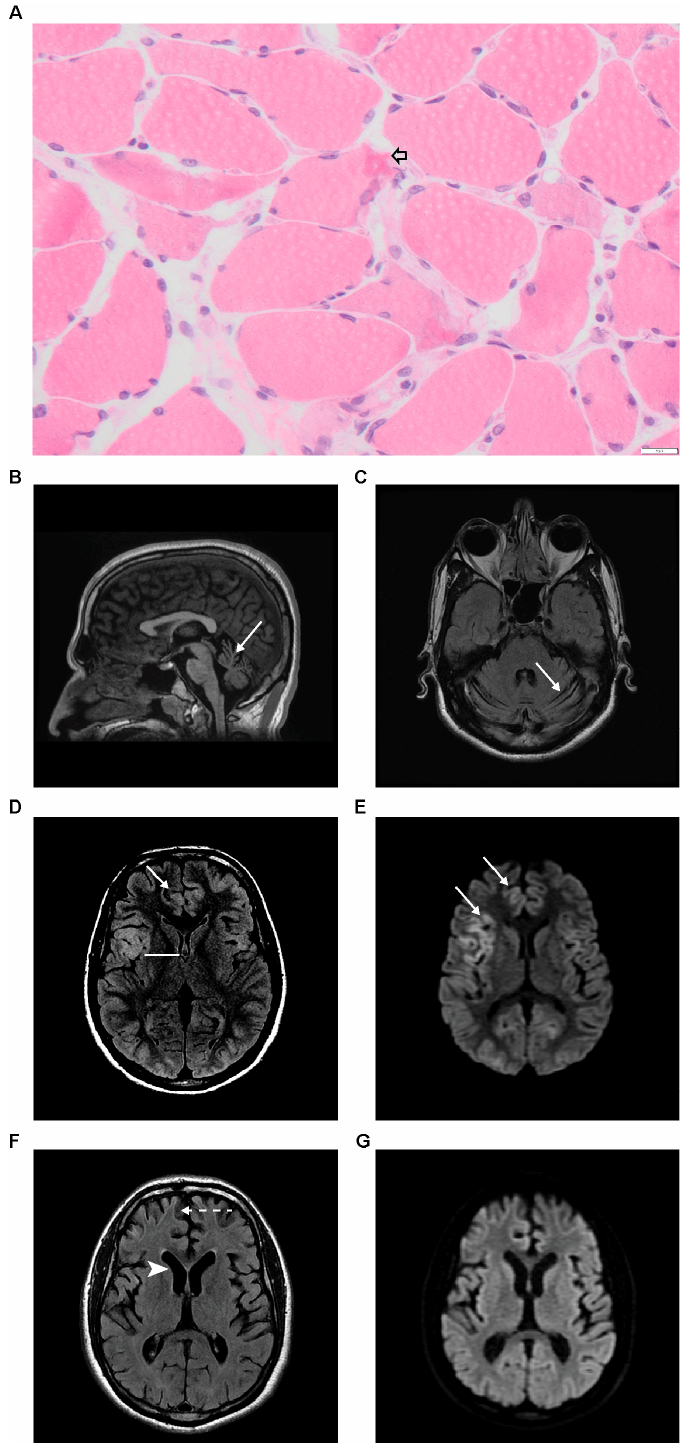
Figure 1. Muscle biopsy and neuroimaging findings in adult patient with NAXD deficiency. ( A ) Skeletal muscle showing rounded eosinophilic cytoplasmic bodies (arrow). Haematoxylin and eosin-stained section taken at 400× magnification (scale bar bottom right—20 μ m). Initial MRI brain (first row) showing isolated moderate cerebellar volume loss (thin arrows in ( B ) and ( C )). Second MRI (second row) performed 5 weeks later shows bilateral multifocal areas of cortical swelling and increased FLAIR signal intensity (block arrow in ( D )). The corresponding areas demonstrate diffusion restriction (arrow in ( E )), suggestive of cytotoxic oedema. Repeat MRI (last row)